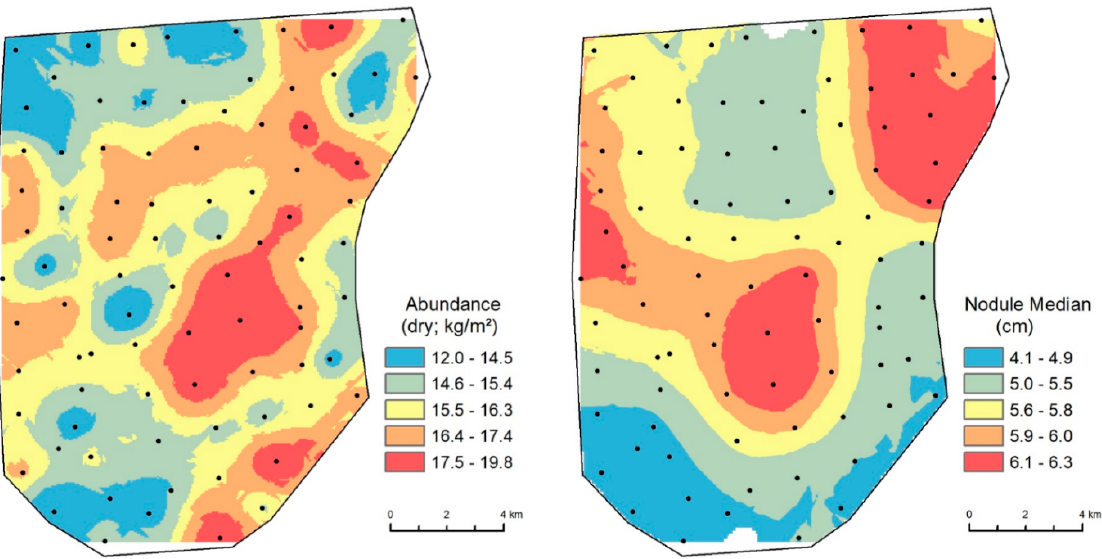
Figure 16. Filled contour maps of nodule abundance ( left ) and nodule size distribution ( right ) in PA1-West. Black dots represent box core locations.